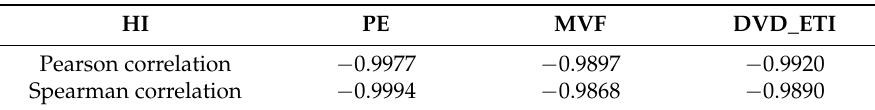
Table 2. Similarity analyses comparison by battery No.